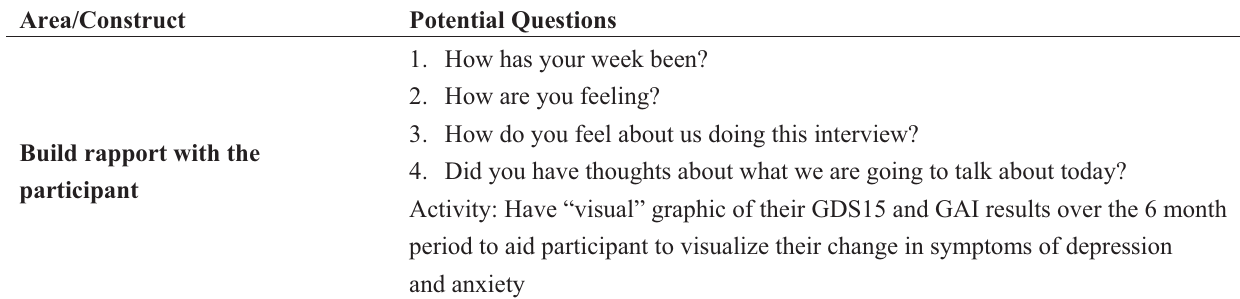
Table A2. Proposed question set for the qualitative semi-structured interviews at completion of the overall